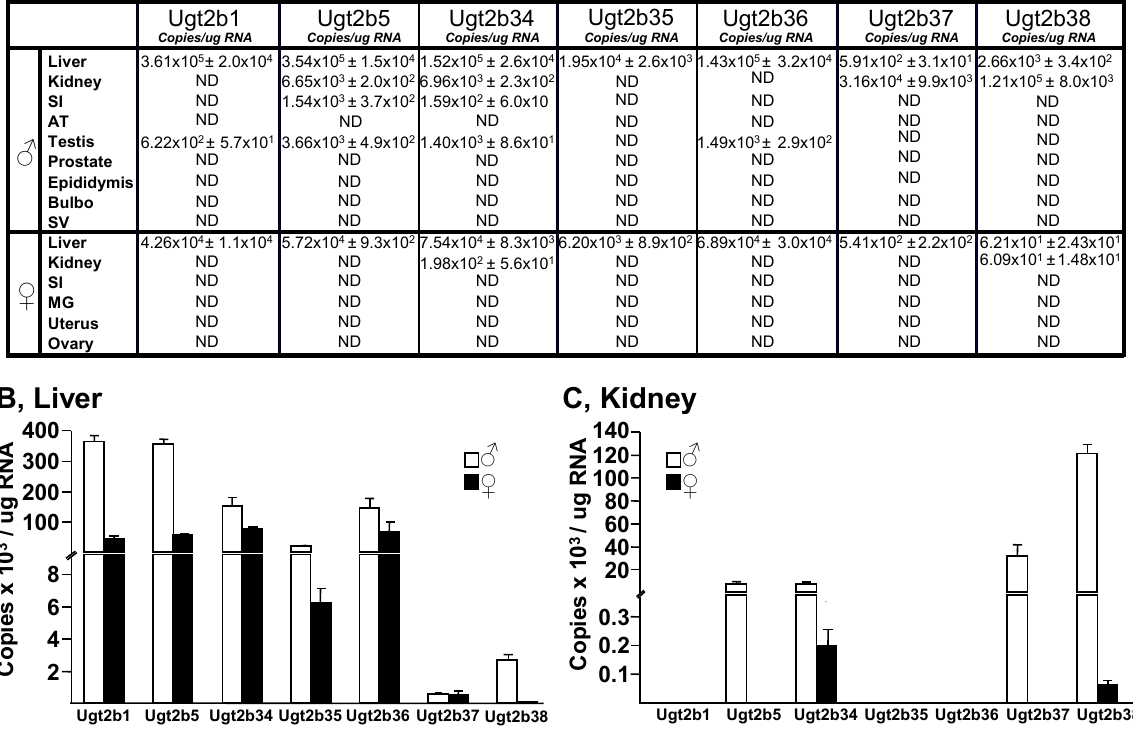
Figure 2. Tissue distribution of murine Ugt2b transcripts. Total RNA from male and female mice (n = 3/sex) tissues were extracted, reverse-transcribed, and analyzed for the expression of the seven Ugt2b enzymes through qRT-PCR analyses (Table 1). The Ugt2b copy numbers in all tissues ( A ) including Liver ( B ) and Kidney ( C ) were obtained using linear regression with a standard curve that included five log concentrations of the Ugt2b plasmids. Experiments were performed in triplicate. SI, small intestine; AT, adipose tissue; SV, seminal vesicle; MG, mammary gland. ND: not detected. Overall, these experiments point-out: (i) the Ugt2b1, 2b5, and 2b34 enzymes as